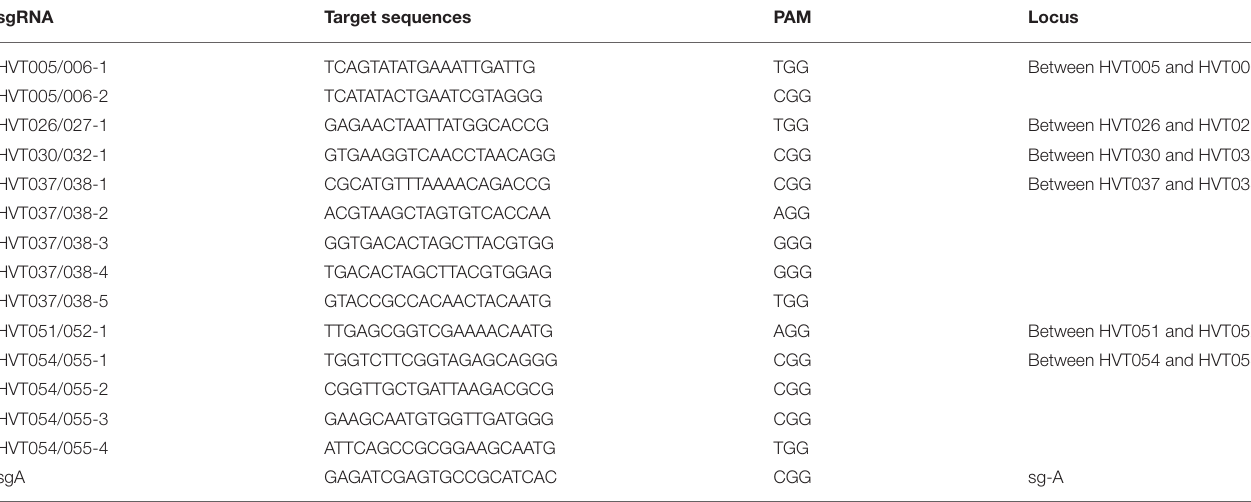
TABLE 1 | sgRNA targeting sequences of the HVT genome and the donor plasmid.